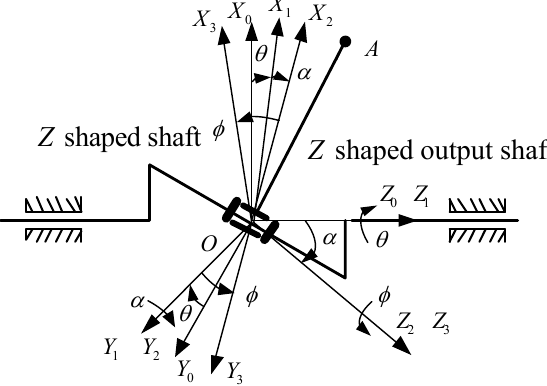
Figure 6. The coordinate systems of the wobble plate joint.